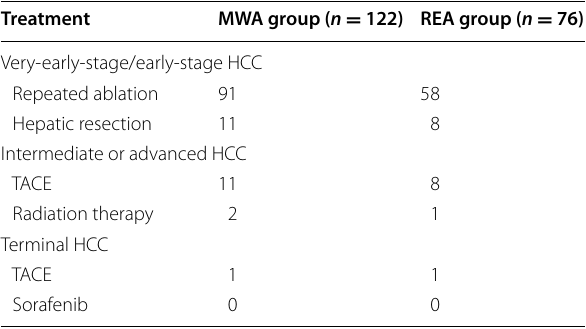
Table 3 Treatments of HCC patients who developed